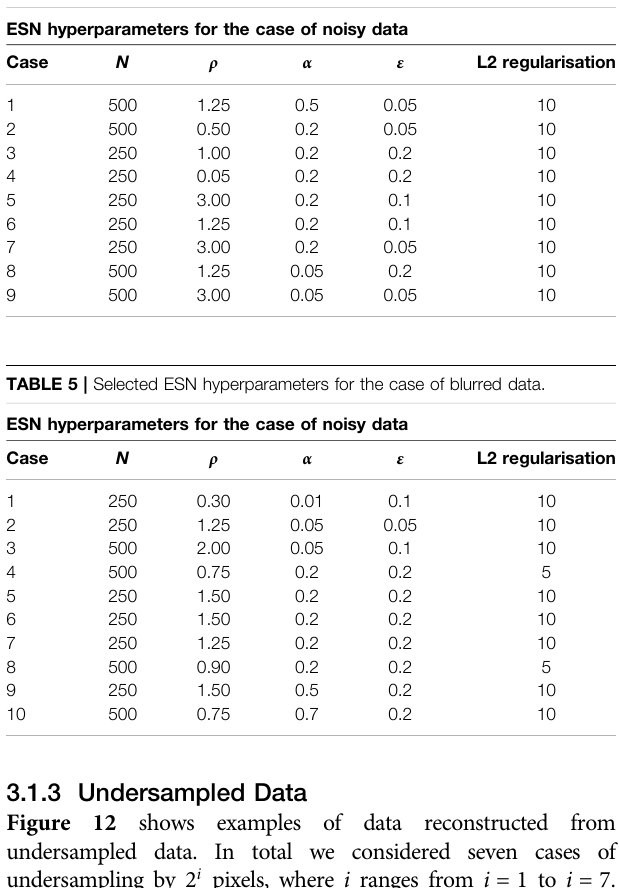
TABLE 4 | Selected ESN hyperparameters for the case of noisy data.